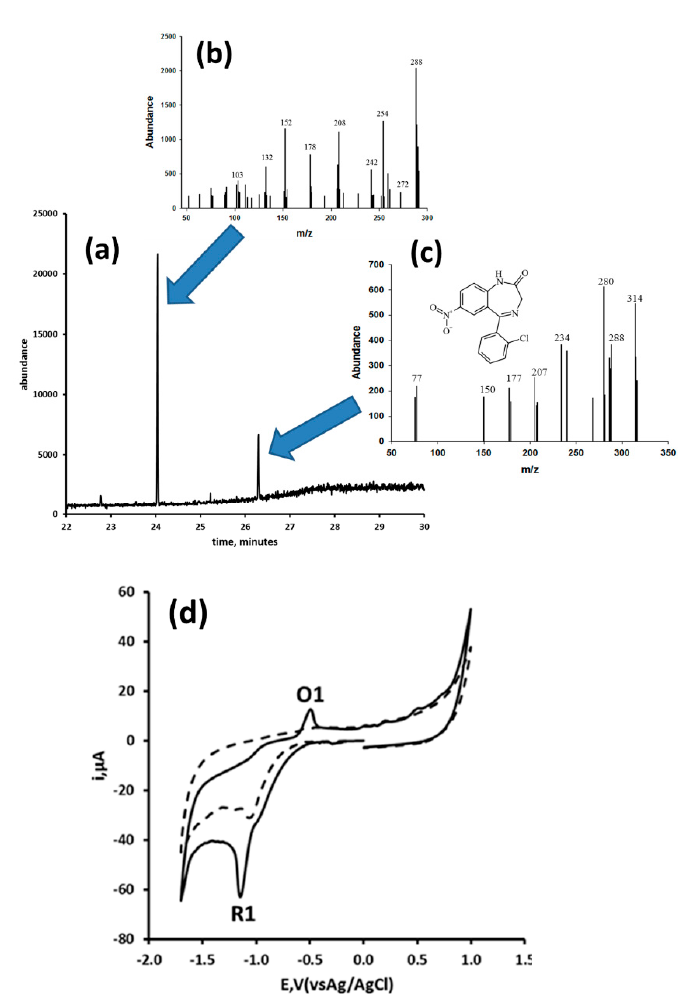
Figure 1. Gas chromatography of clonazepam and possible base hydrolysis product. ( a ) Full scan chromatogram; ( b ) hydrolysis mass spectrum (retention time 24.1 min); ( c ) clonazepam mass spectrum (retention time 26.2 min); and ( d ) cyclic voltammogram obtained in pH 11 phosphate buffer for a 1 mM clonazepam solution [116].